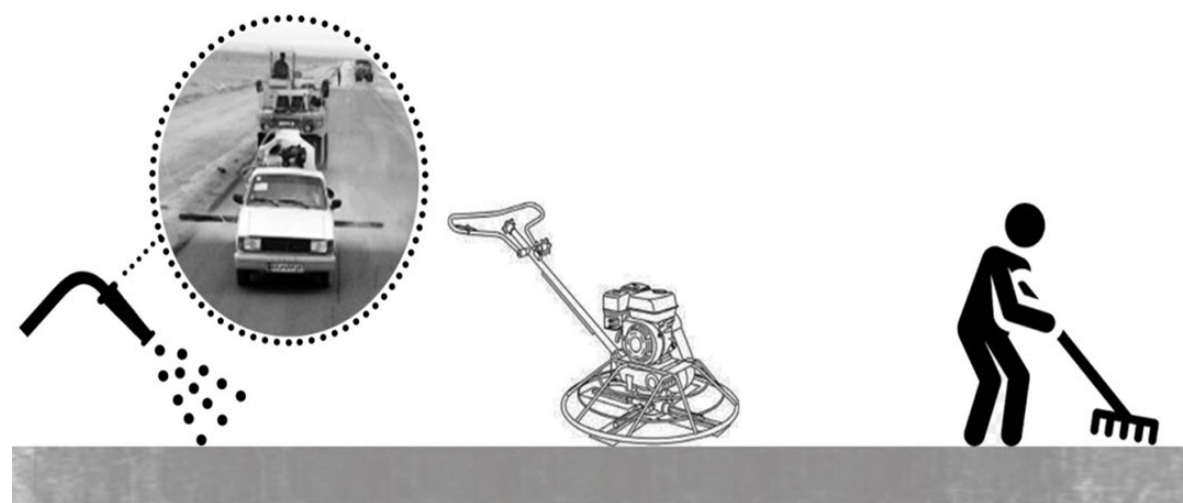
Figure 4. Steps of the brooming texture (the picture is author-originated: spaying on RCCP and passing heavy pneumatic tire roller on the RCCP